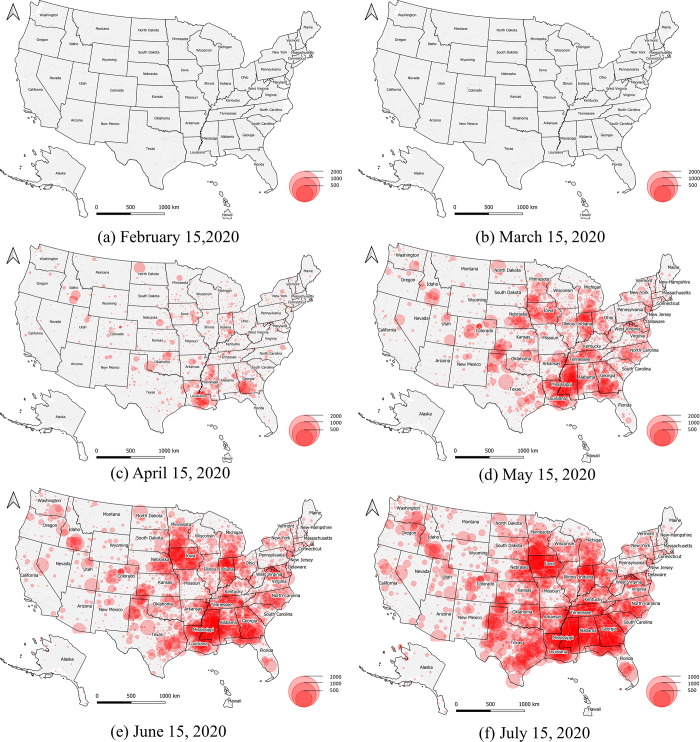
General MRDI trend.